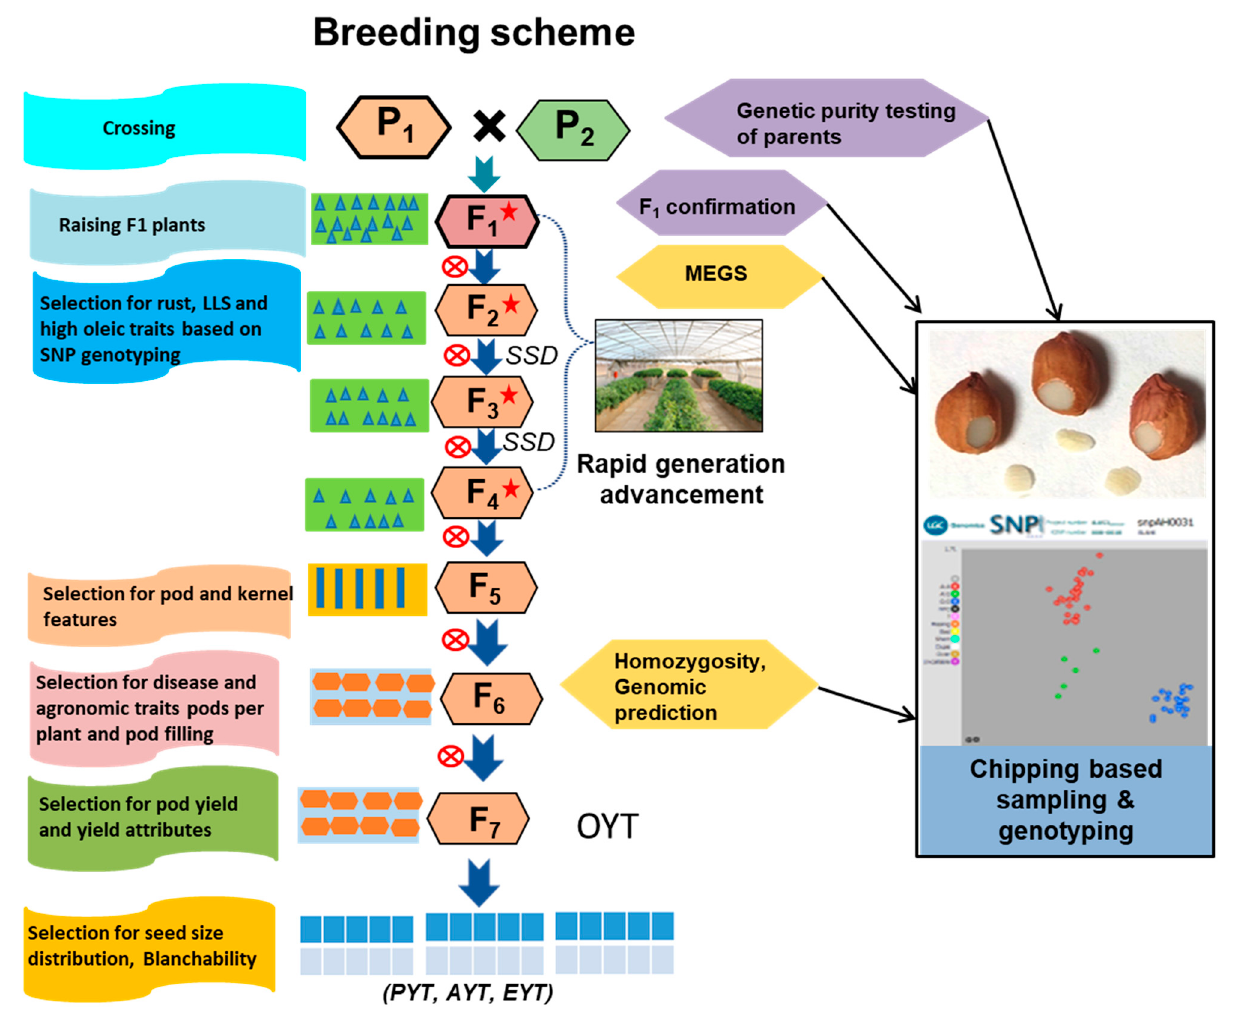
Figure 6. Applications of seed-chipping in routine groundnut breeding program and its integration with rapid generation advancement for accelerated groundnut breeding.